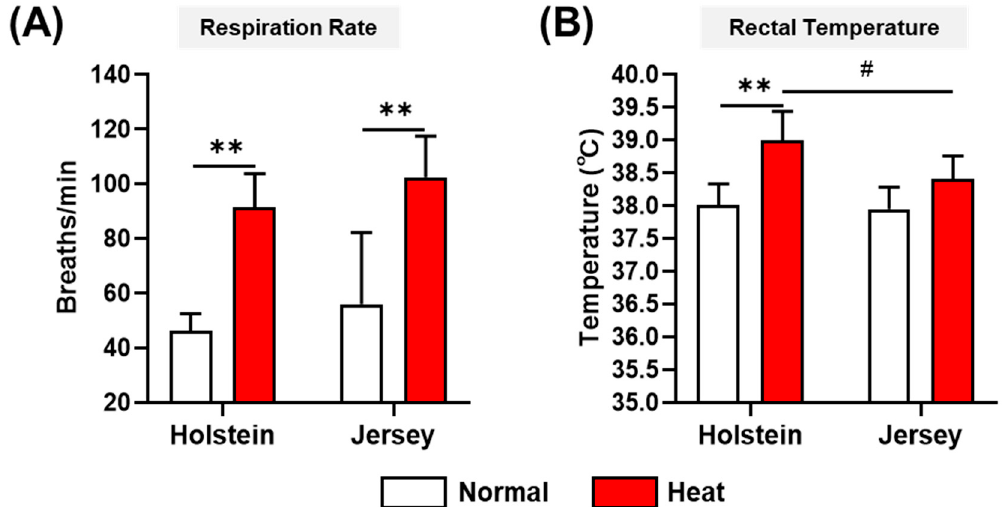
Figure 2. Physical heat stress parameters of two breeds of dairy cow under different environmental conditions. Measurements of respiration rate ( A ) and rectal temperature ( B ) for Holstein and Jersey cows under normal environmental conditions (Normal, THI = 69.6) and high-heat environmental conditions (Heat, THI = 87.5). Data are represented as means ± standard deviation (SD); n = 8 animals/group. Values were statistically analyzed by two-way repeated measure ANOVA with Tukey’s multiple comparison test. ** p < 0.01 and # p < 0.1.